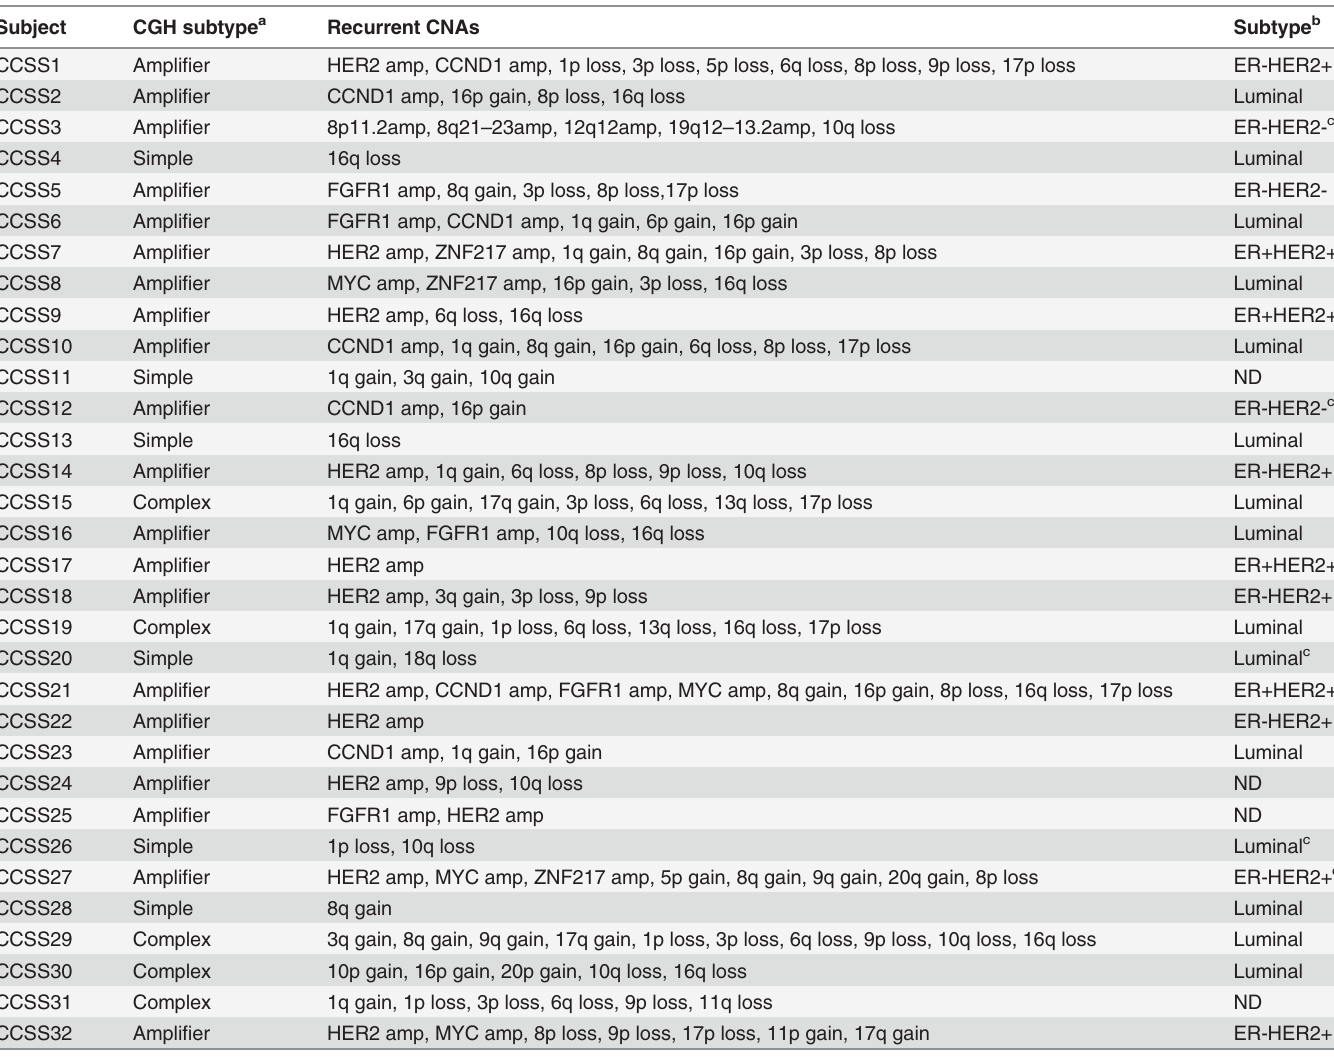
Table 3. ArrayCGH pro fi le and molecular subtypes of CCSS cases included in this